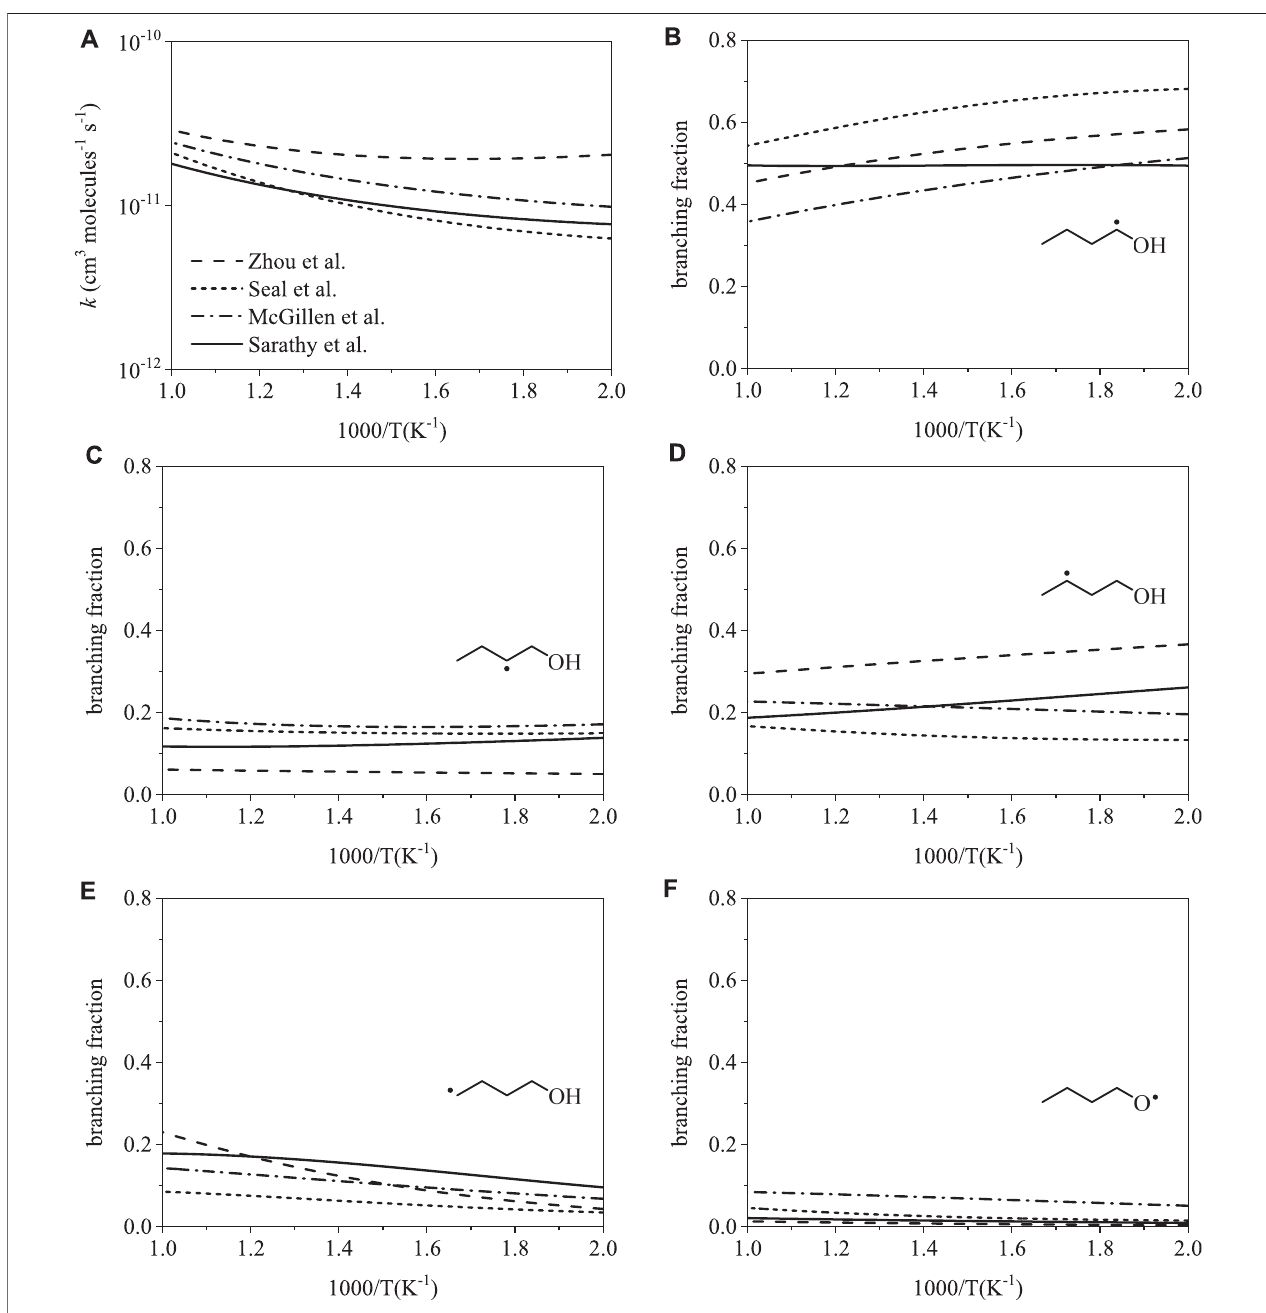
FIGURE 2 | Rate coef fi cients from Sarathy et al. (Sarathy et al., 2012), Zhou et al. (Zhou et al., 2011), Seal et al. (Seal et al., 2013), McGillen et al. (McGillen et al., 2013): (A) total, (B – F) site-speci fi c. Despite relative consistency in total rate coef fi cients, branching fractions for OH-initiated H-abstraction differ substantially.